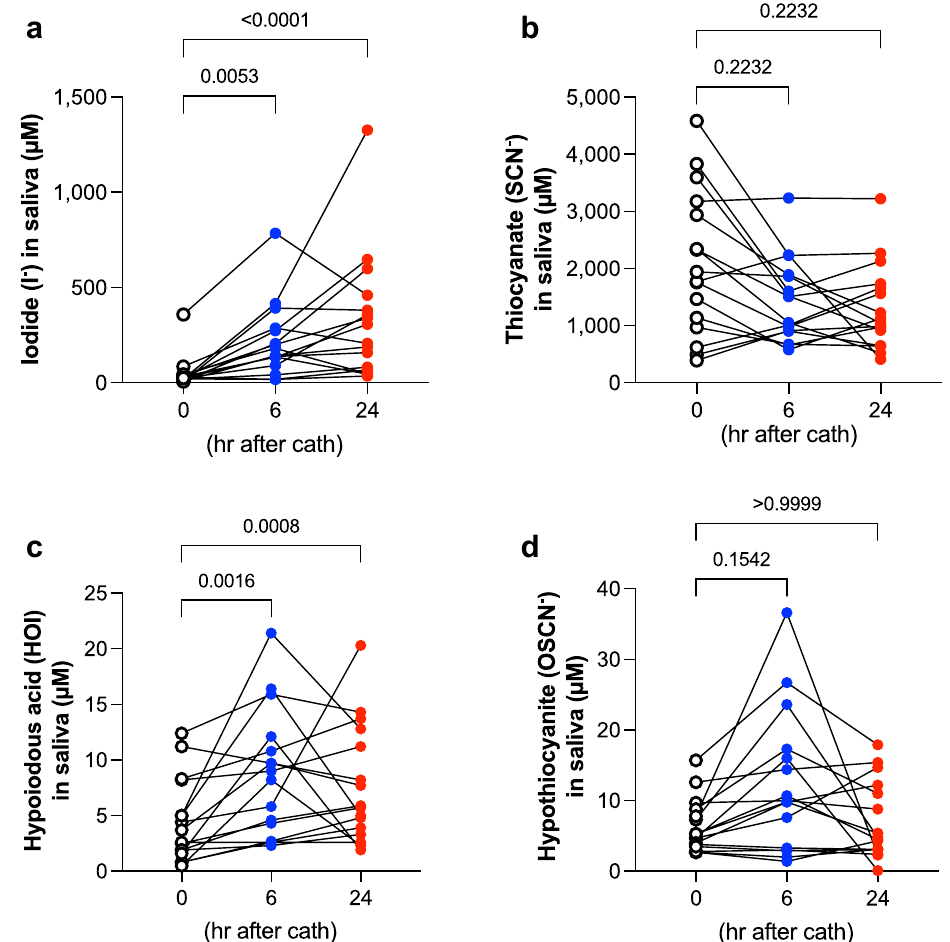
Figure 2. Study 2: Salivary contents of iodide, thiocyanate (SCN − ), hypoiodous acid (HOI) and hypothiocyanite (OSCN − ) before, 6 h and 24 h after an iodinated contrast load. Saliva was collected before (0 h), 6 h and 24 h after an iodinated contrast load. Salivary levels of iodide ( a ), SCN − ( b ), HOI ( c ), and OSCN − ( d ) were measured as indicated in Methods. All data were analyzed by Friedman test, two-tailed, followed by Dunn’s multiple comparison test (n = 16 pairs). P values vs. 0 h shown above brackets.